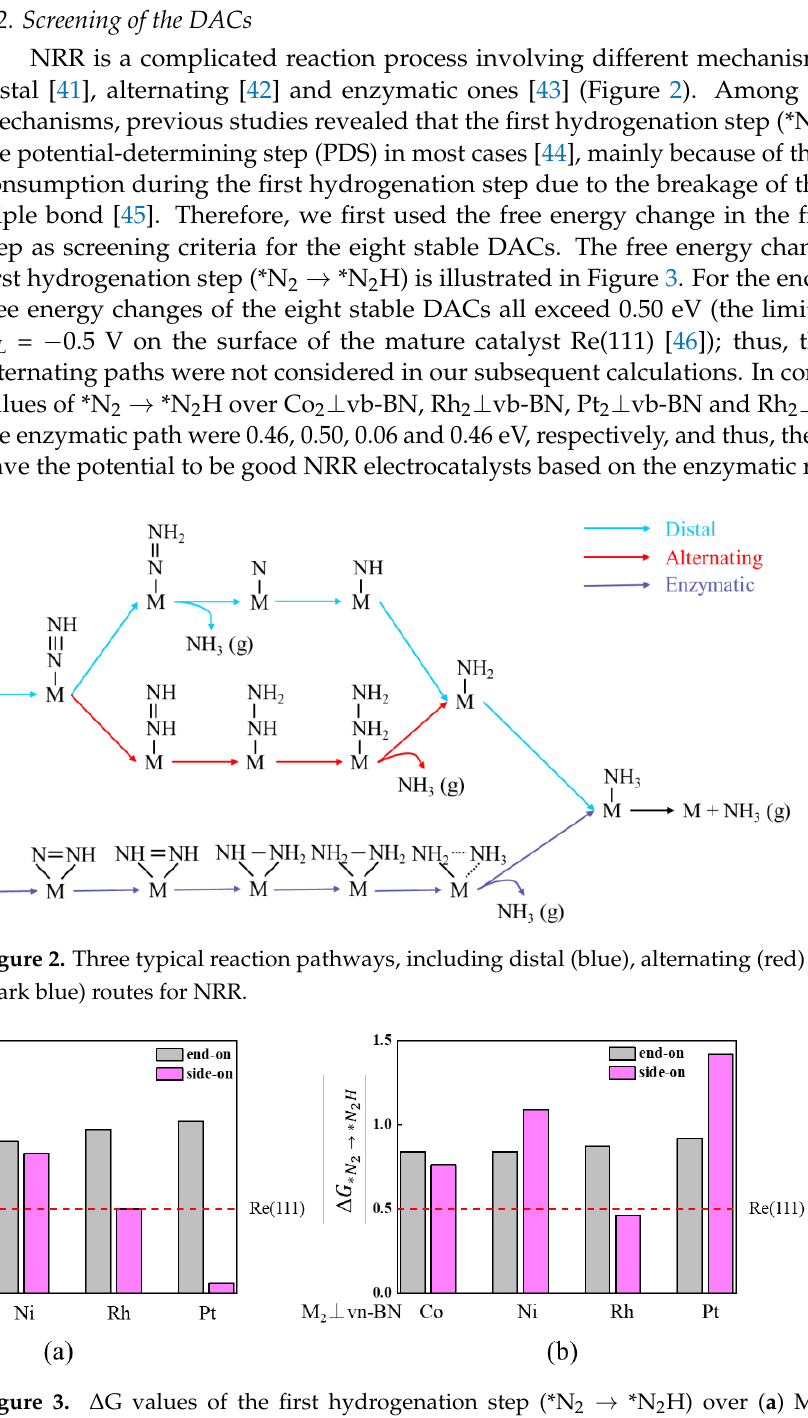
Figure 3. ∆ G values of the first hydrogenation step (*N 2 → *N 2 H) over ( a ) M 2 ⊥ vb-BN and ( b ) M 2 ⊥ vn-BN.